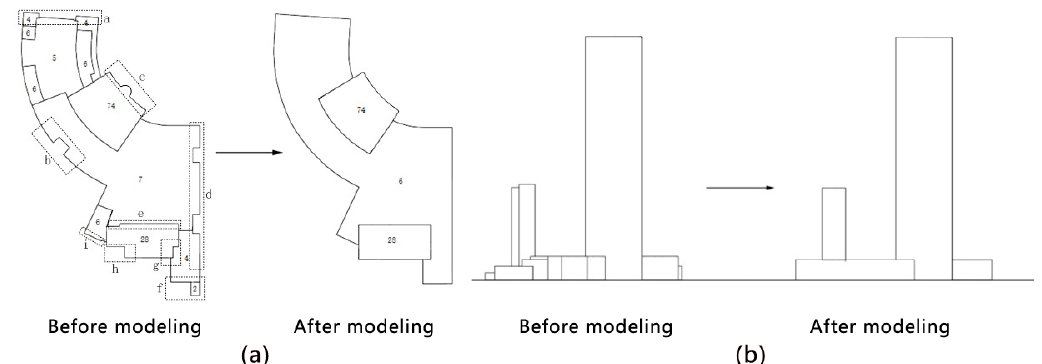
Figure 4. Plane and elevation modeling principles of the urban energy consumption model: ( a ) plane before modeling and after modeling; ( b ) elevation before modeling and after modeling. Plane modeling is used to import graphic data from urban buildings and model the outline of each building to eliminate concave and convex outlines.